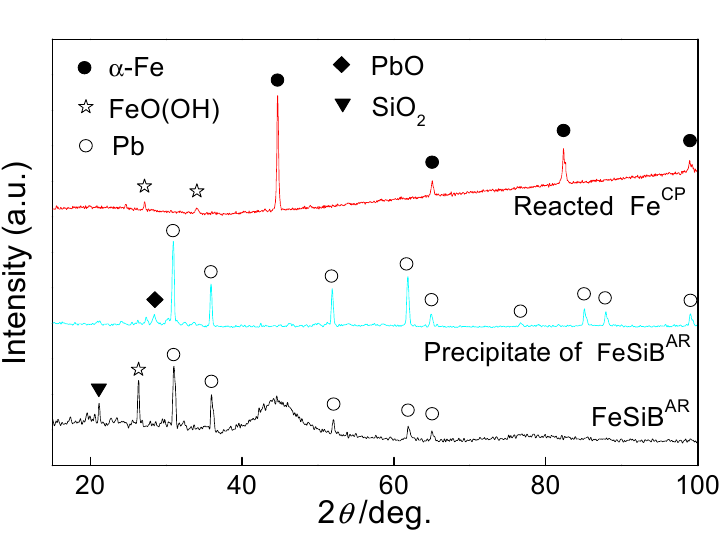
Figure 5. XRD patterns of the reacted FeSiB AR and Fe CP , and XRD pattern of the precipitate from the aqueous solution reacted with FeSiB AR .